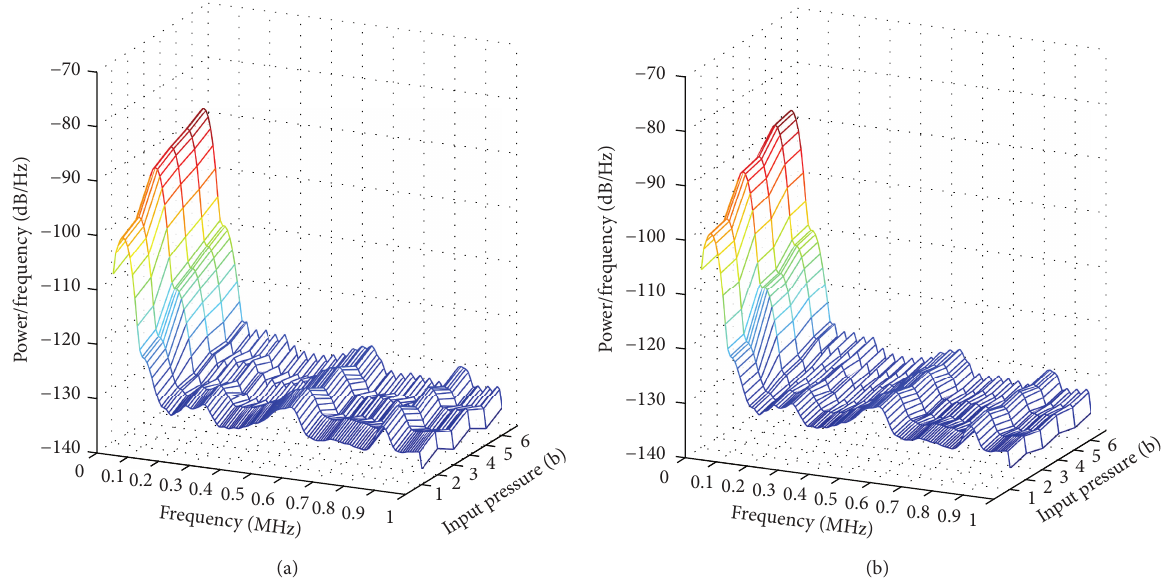
Figure 14: Power spectral density of raw AE signal due to VL through 0.1 mm lifted valve in cylinder 4. (a) Exhaust valve and (b) intake valve.